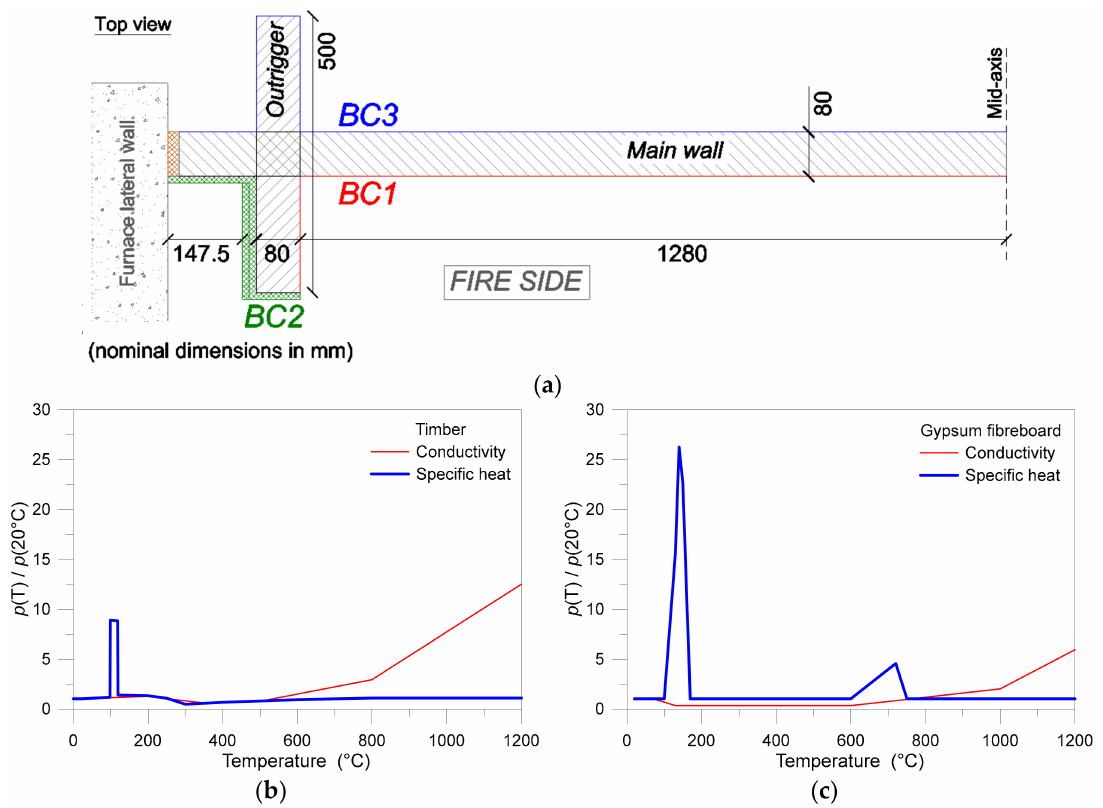
Figure 8. ( a ) Boundary conditions for the thermo-mechanical analysis of the W80 specimen, with ( b , c ) timber and gypsum fibreboard variation of thermo-physical properties, as a function of